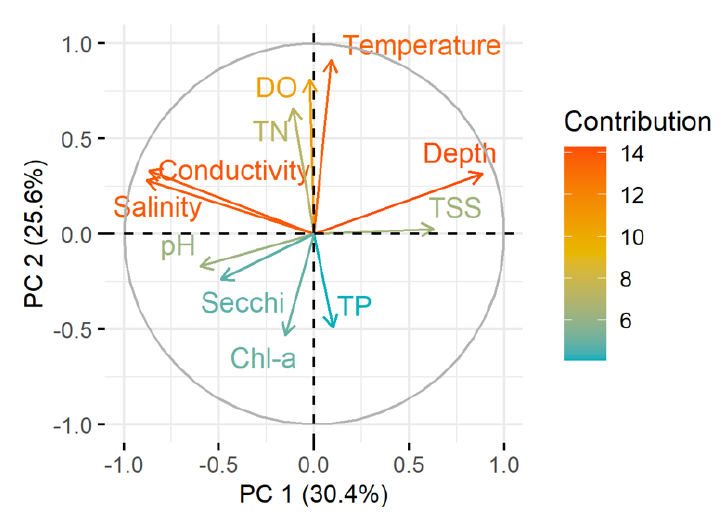
Figure 2. Biplot of principal component analysis (PCA) of the environmental variables, where axis 1 explained 30.4% and axis 2 explained 25.6% of the total variation. The strength of the contribution of variables is indicated by the colour range of the arrows. All data were log 10 transformed.